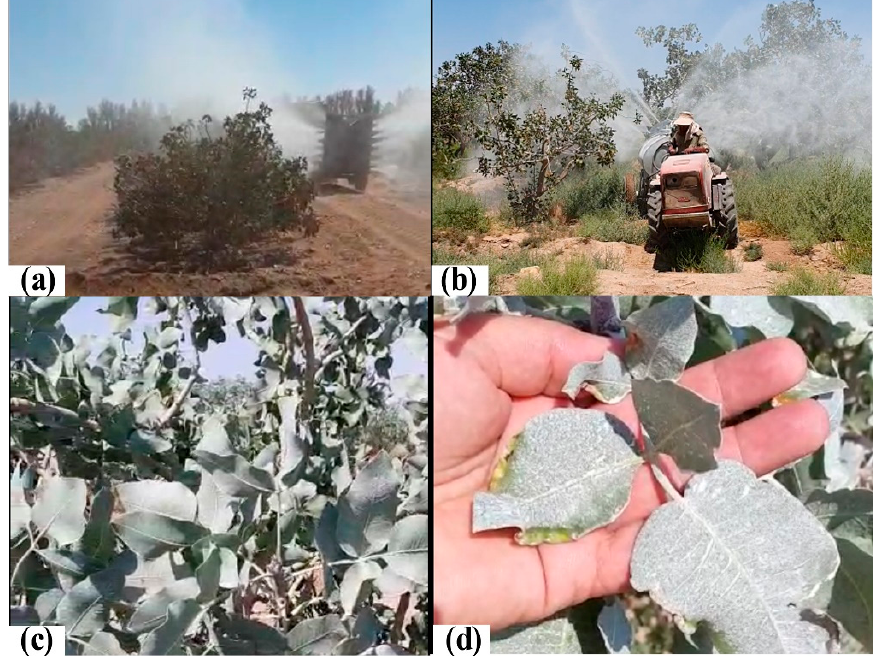
Figure 3. ( a , b ) Foliar spraying of pistachio trees, and ( c , d ) close-up views of the leaves of after spraying.